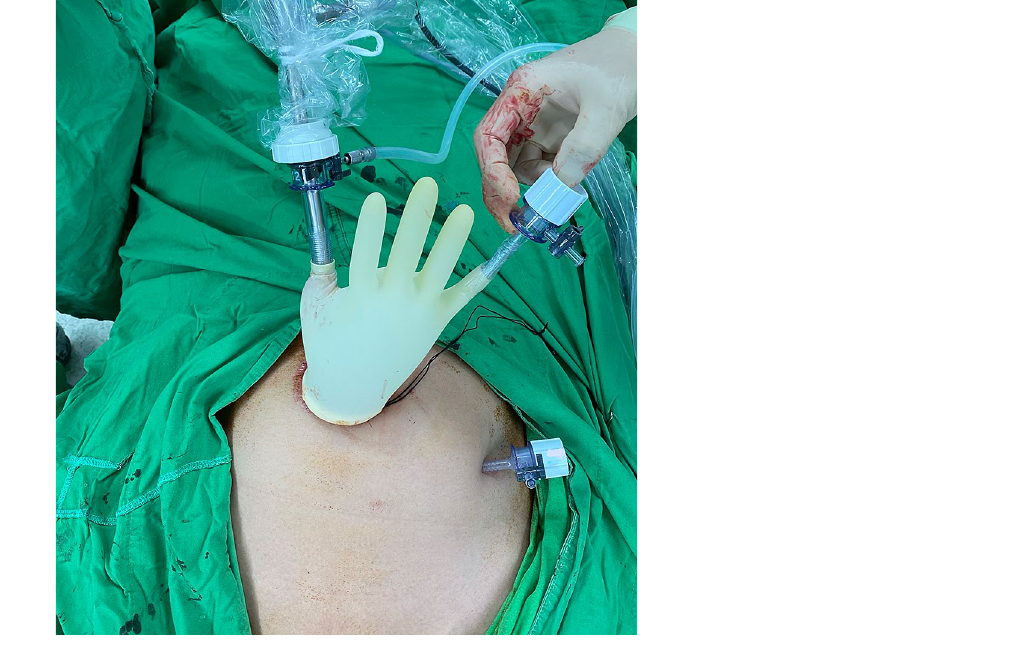
Figure 2. Two-port laparoscopic